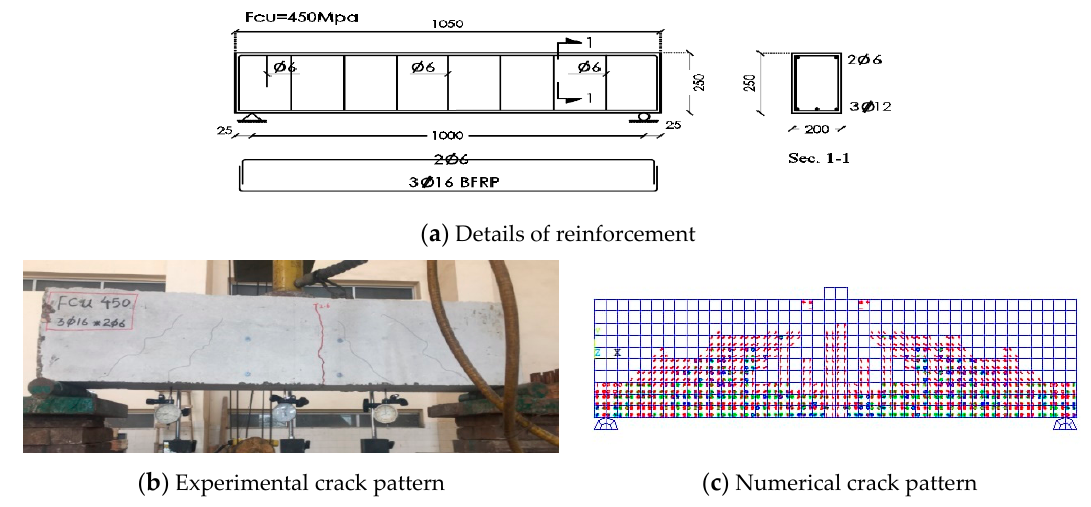
Figure 22. Beam B7 modeling.